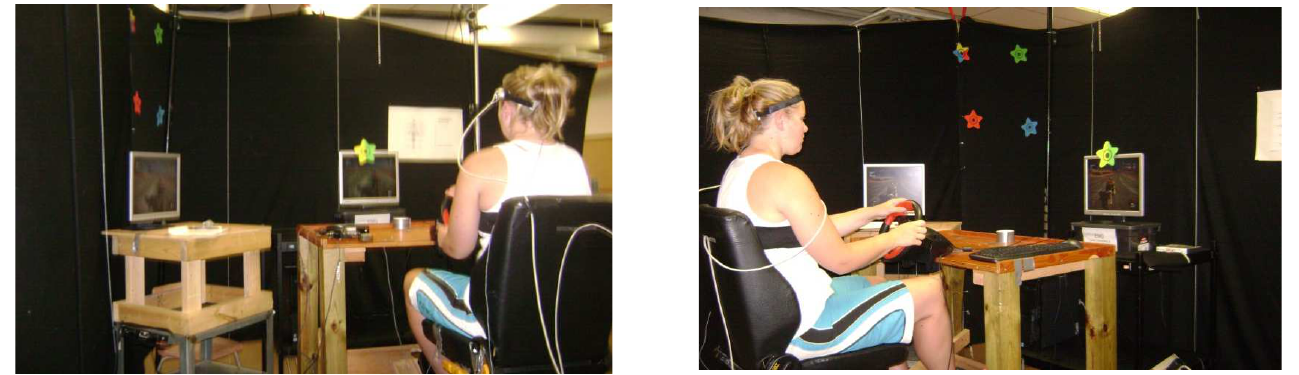
Figure 1. Example of a participant test session with full equipment set-up.